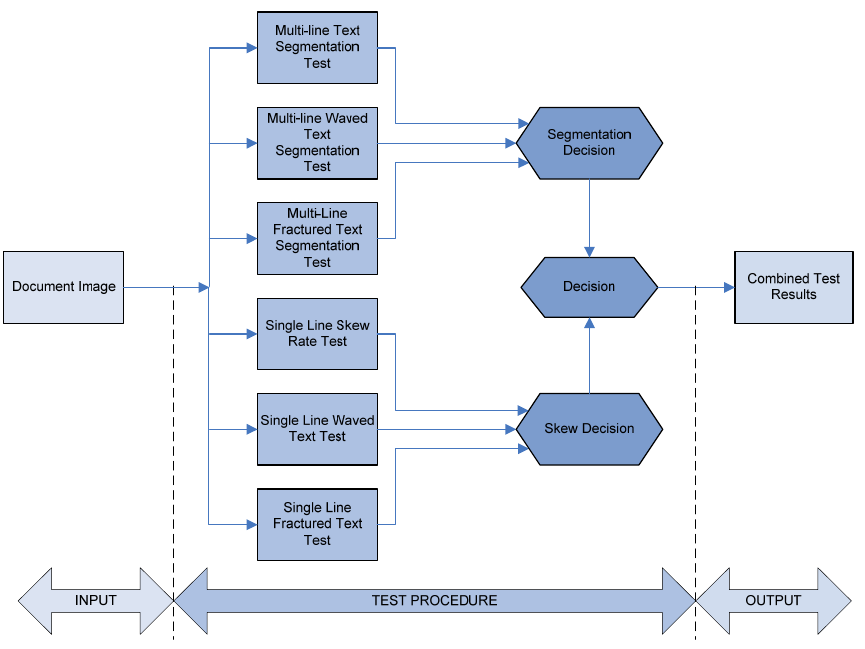
Figure 1. Integral framework test